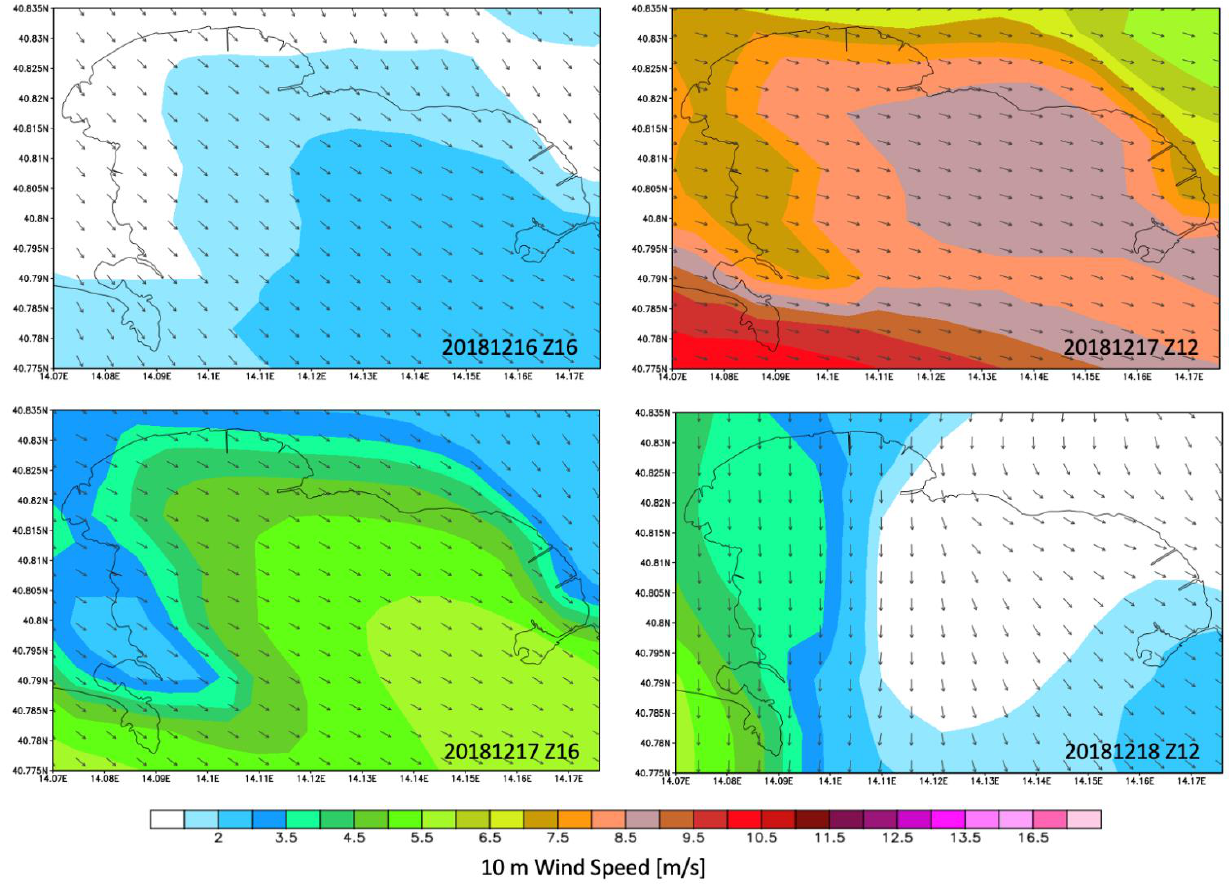
Sensors 2021 , 21 , x FOR PEER REVIEW Figure 5. Maps of wind speed and wind direction in the study area between 16 and 18 December 2018.